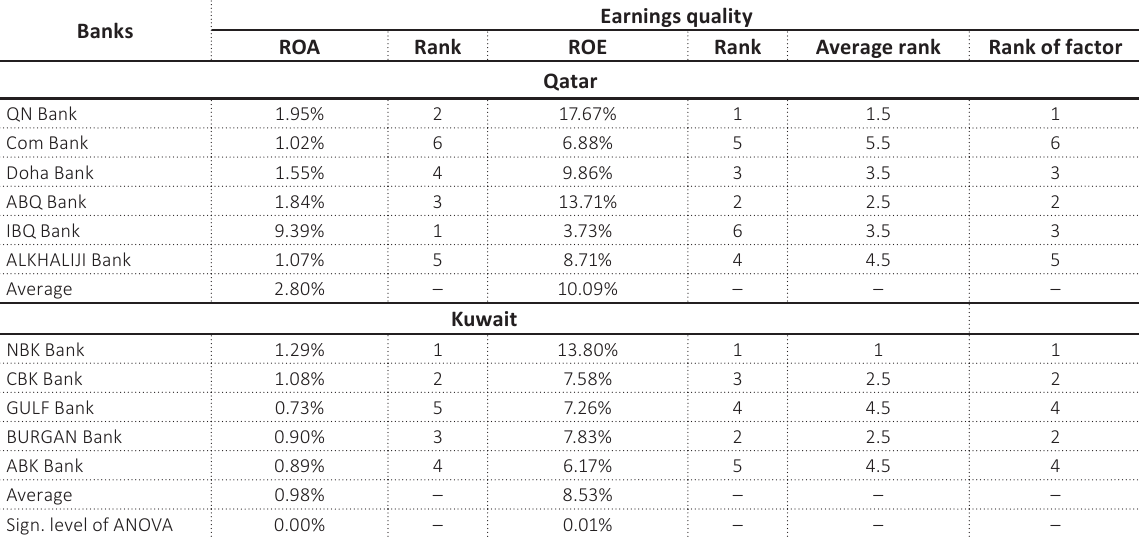
Table 6. Average ratios of years and rankings in the case of the Earnings quality factor at selected